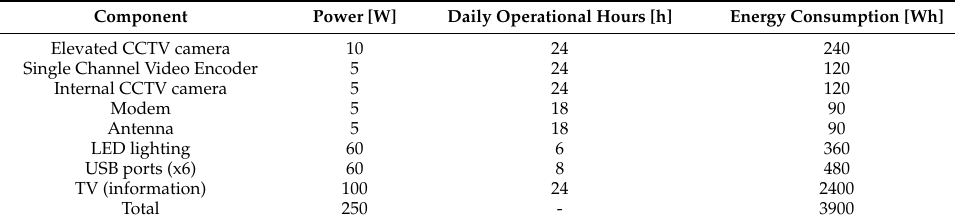
Table 4. Service and energy requirements of the solar station.